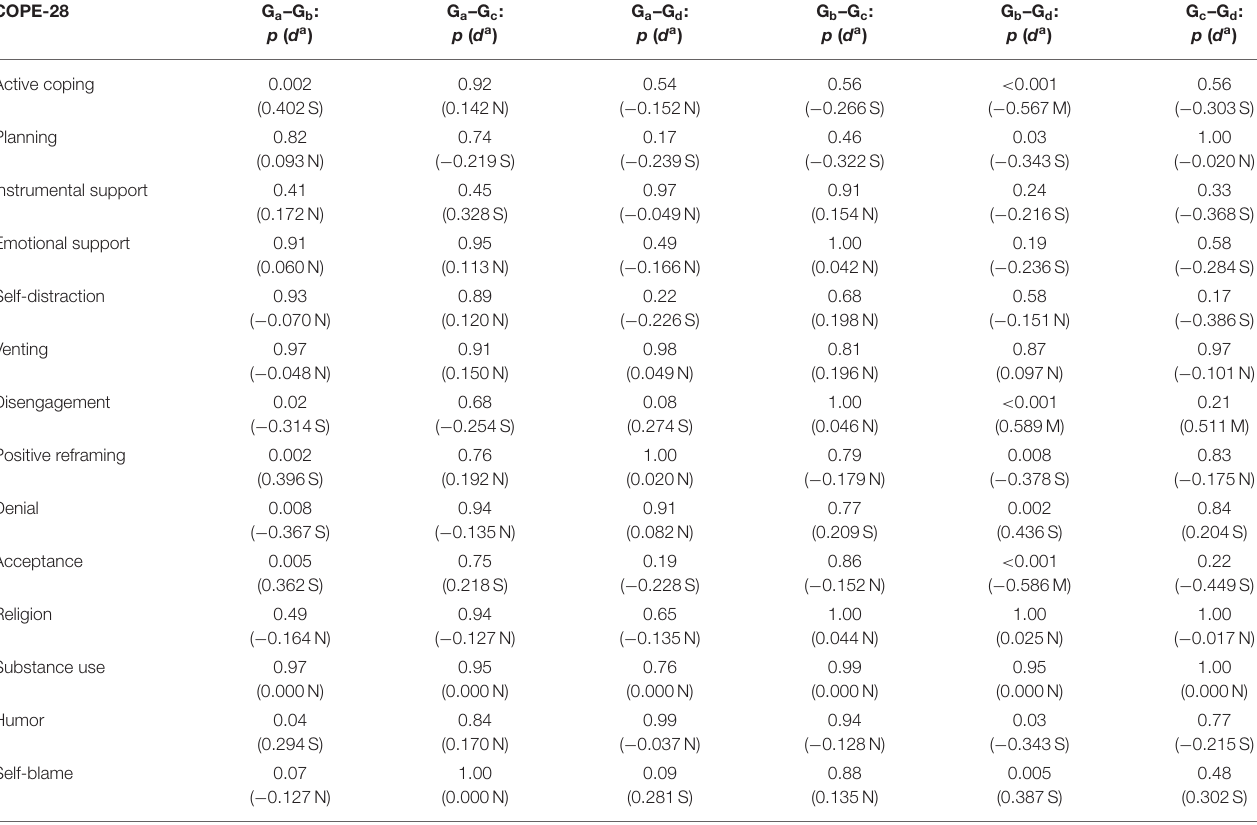
TABLE 10 | Post hoc comparison of coping strategies (COPE-28) between non-alcoholic fatty liver disease (NAFLD) severity groups: non-alcoholic steatohepatitis (NASH; with and without significant fibrosis) and no-NASH (with and without significant fibrosis). COPE-28